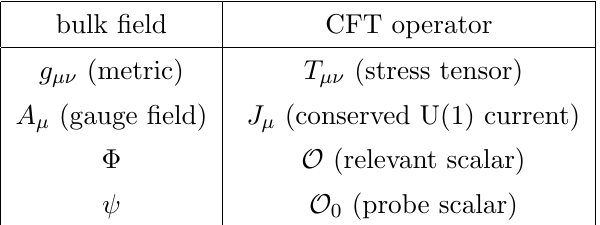
Table 2 . The four bulk (cid:12)elds of (3.1), and their dual operators in the CFT of interest. Our interest will be in the in(cid:13)uence of (and hence (cid:8)) on the two-point correlators of T (cid:22)(cid:23) , J (cid:22) and O